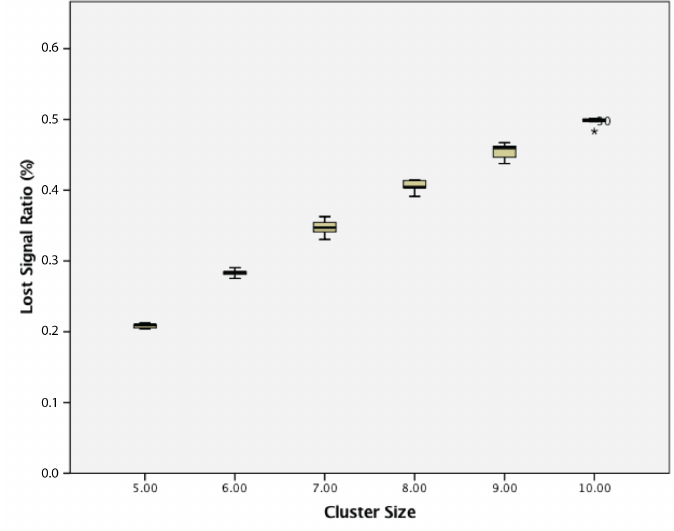
Figure 12. Lost signal ratio of cluster of 5–10 passive wireless sensor nodes with a 5 s transmission interval.